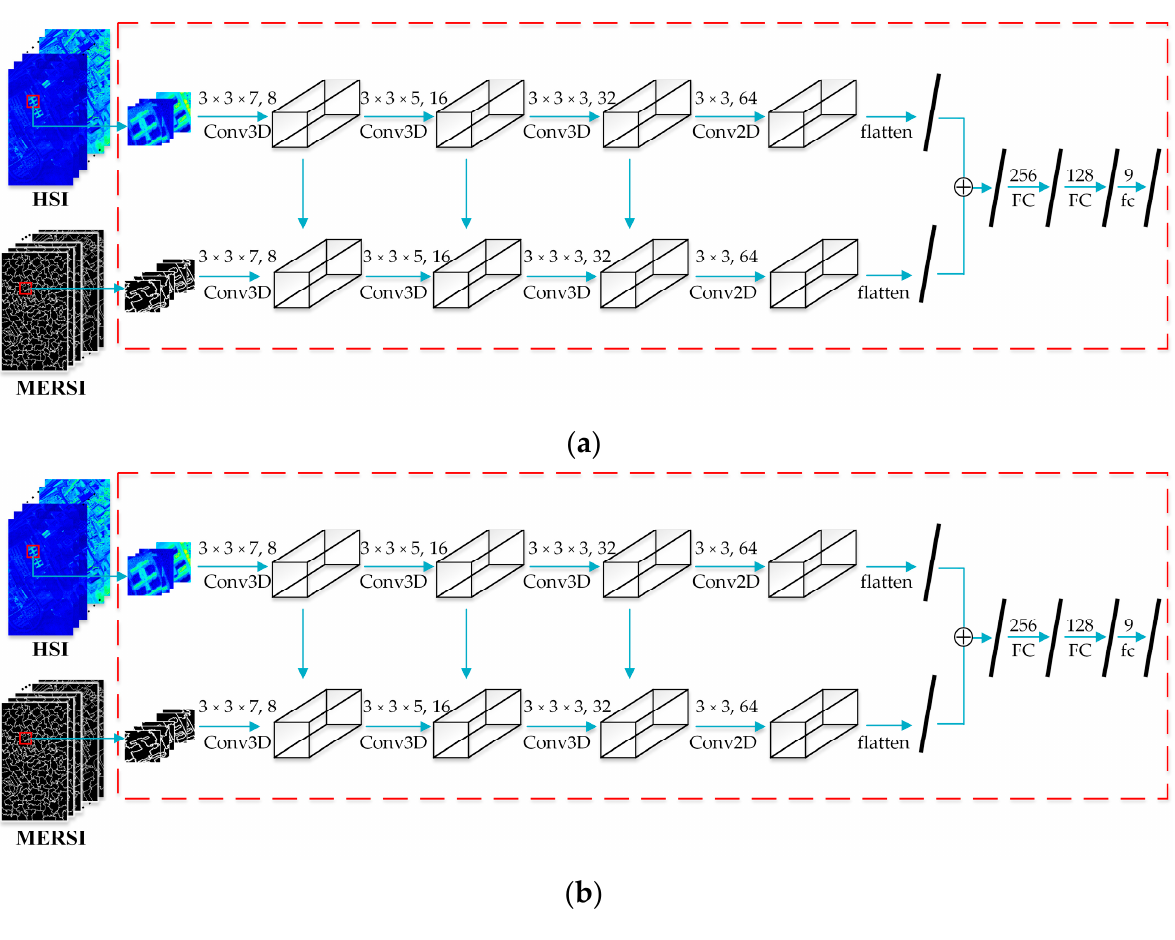
Figure 8. Network structures of two variants of TBN-MERS: ( a ) TBN(M2H)-MERS and ( b ) Figure TBN(H2M)-MERS. Table 9. Classification results of TBN(M2H)-MERS, TBN(H2M)-MERS, and TBN-MERS.